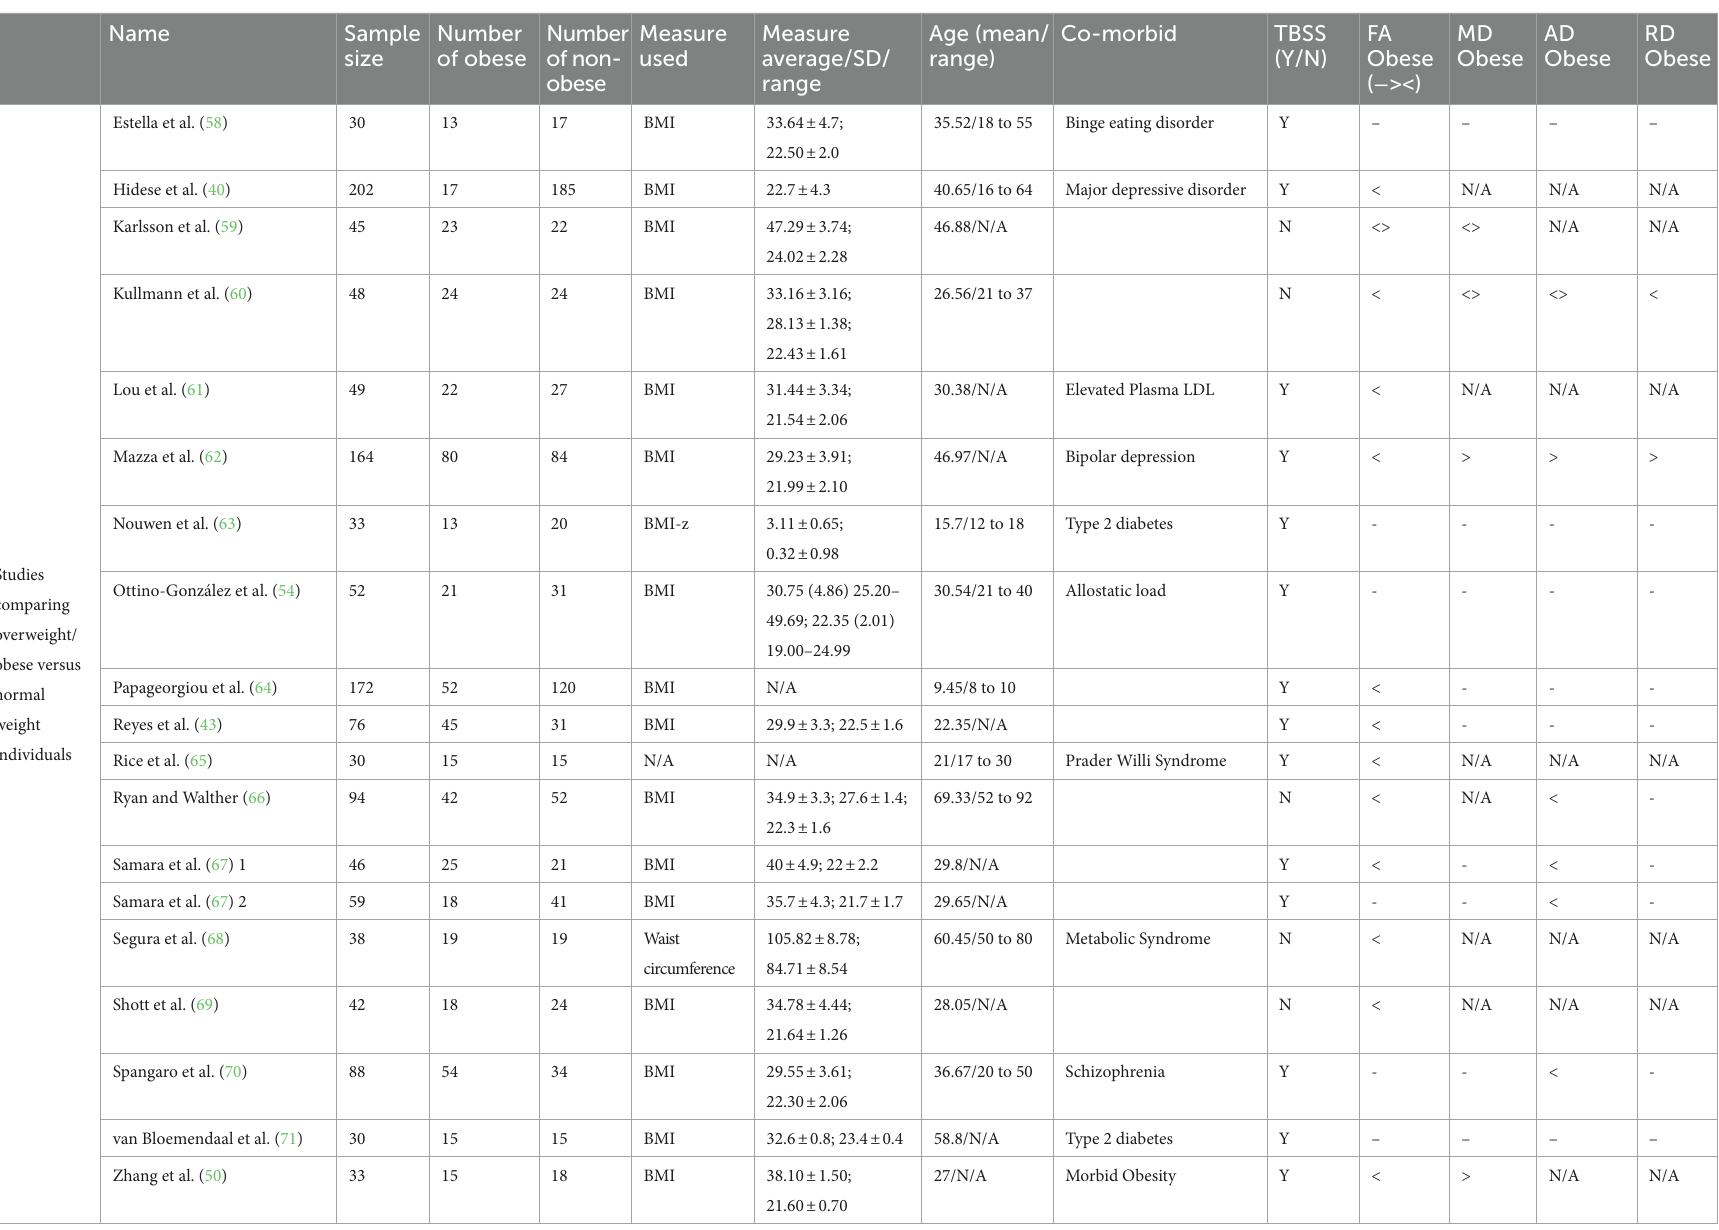
TABLE 1 Summary of the studies included in the spatial voxel-based